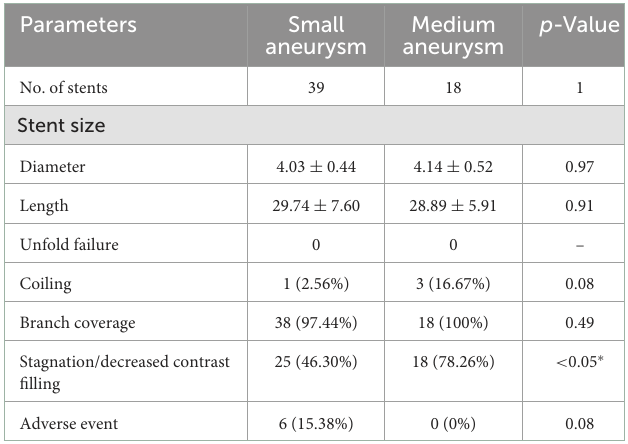
TABLE 1 Baseline characteristics of enrolled